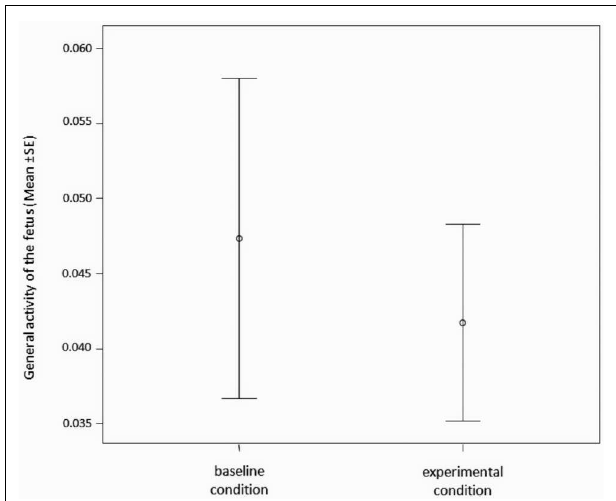
FIGURE 3 | Time frequency of the general behavioral activity of the fetus (number of FOM + FCH + NEX + LP + YW/seconds of observation) during experimental (maternal stimuli administration: LA + LU + MOM + MCH + SYW) and during baseline condition (absence of any kind of